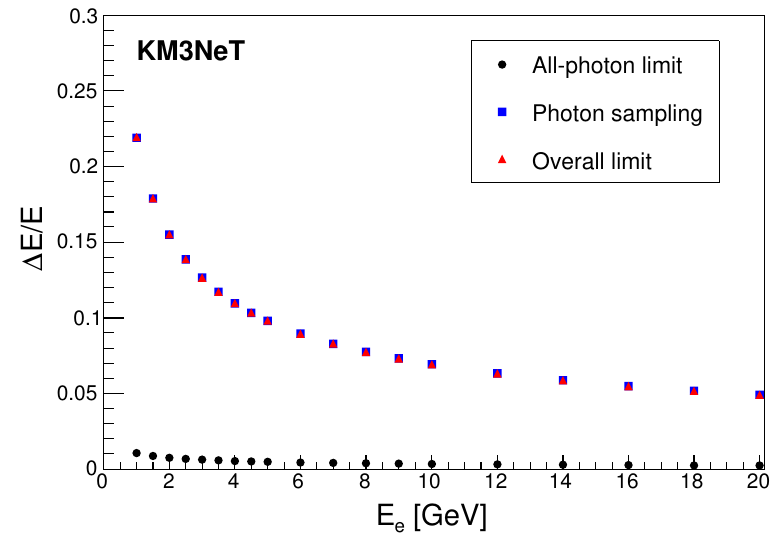
Figure 26 . Limiting relative energy resolutions (RMS) as a function of electron energy E e , for the all-photon limit (black), the error due to photon sampling (blue, overplotted by red), and for the overall limit